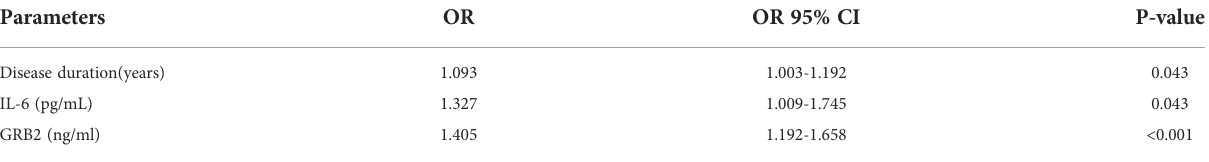
TABLE 7 Multivariate logistic regression analysis with whether CIMT is thickened as the dependent variable.